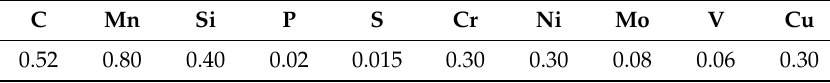
Table 7. Chemical composition in wt % of the EN 13262-ER7